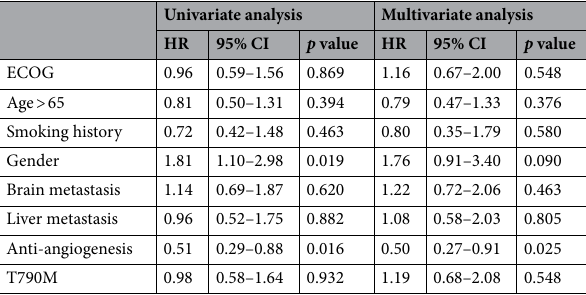
Table 2. Cox regression overall survival